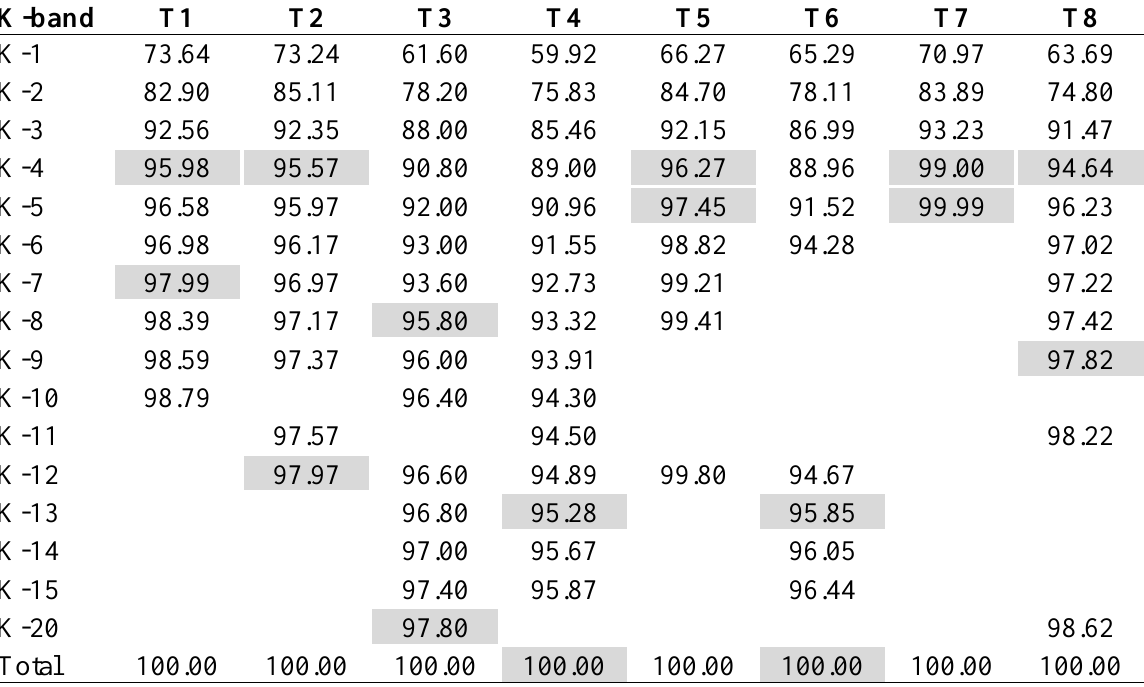
Frequency Profiles of K-1 Through K-20 Bands with 95% and 98%